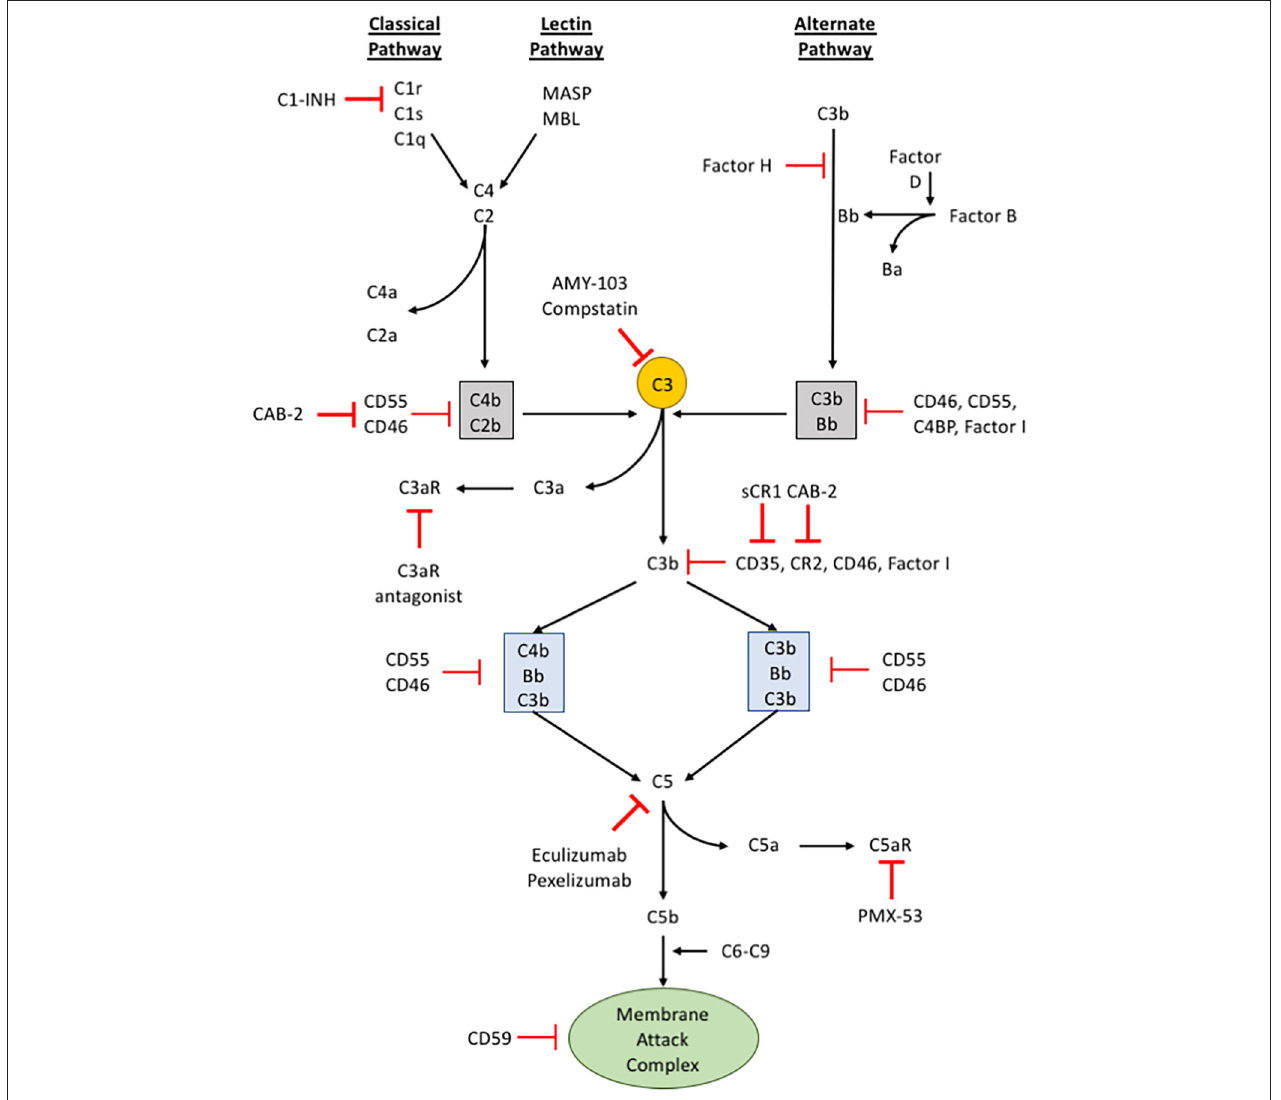
FIGURE 2 | The complement pathway. A schematic of the complement signaling pathway where all 3 pathways (classical, lectin, and alternative) converge on C3. The red, bolded inhibitory signs indicate points in the complement signaling cascade where pharmacologic inhibitors can be used to alter signaling within cells, while the red, unbolded inhibitory sign indicates regulatory proteins in the complement cascade.